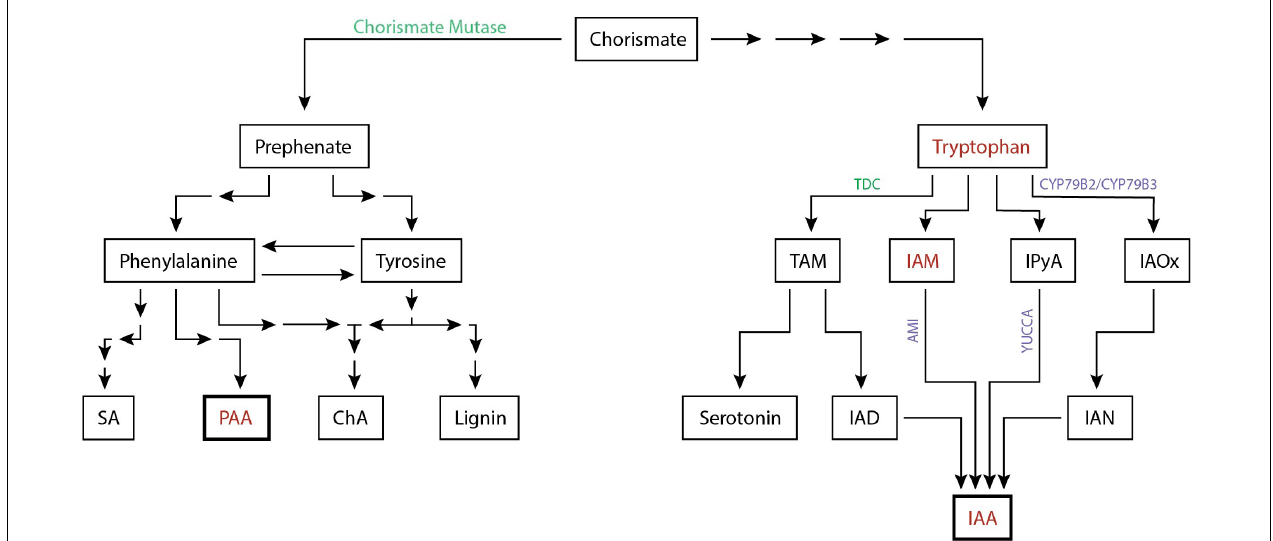
FIGURE 2 | Simplified biosynthesis pathway of the auxins IAA and PAA in plants from the common precursor chorismate. Auxins and auxin precursors for which upregulation is shown are indicated (red). Enzymes involved in the biosynthesis pathway shown to be differentially regulated either at the protein level (green) or at the transcriptome level (purple) are depicted ( Supplementary Table 1 ). The number of arrows indicate the number of conversion steps with four indicating four or more intermediate steps. Converging arrows show a shared intermediary compound. SA, salicylic acid; PAA, phenylacetic acid; ChA, chlorogenic acid; TAM, tryptamine; IAM, indole-3-acetamide; IPyA, indole-3-pyruvic acid; IAOx, indole-3-acetaldoxime; IAD, indole-3-acetaldehyde; IAN, indole-3-acetonitrile; IAA, indole-3-acetic acid.